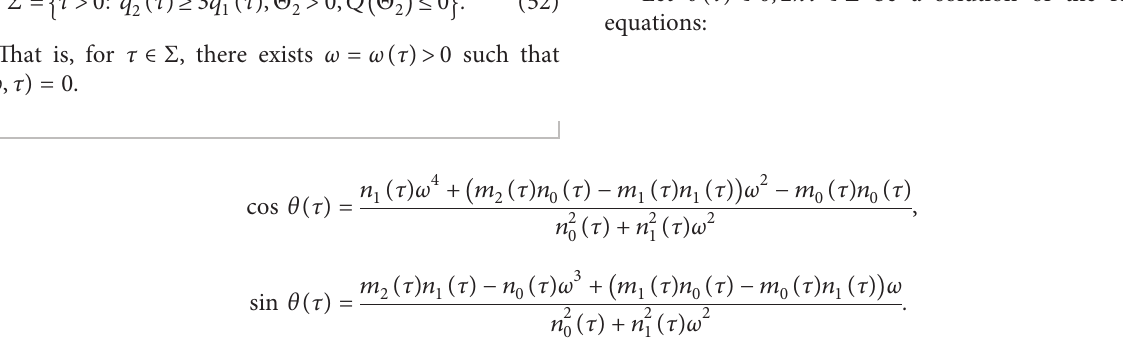
Figure 3: The stability of the computer virus equilibrium E (b) the recovered